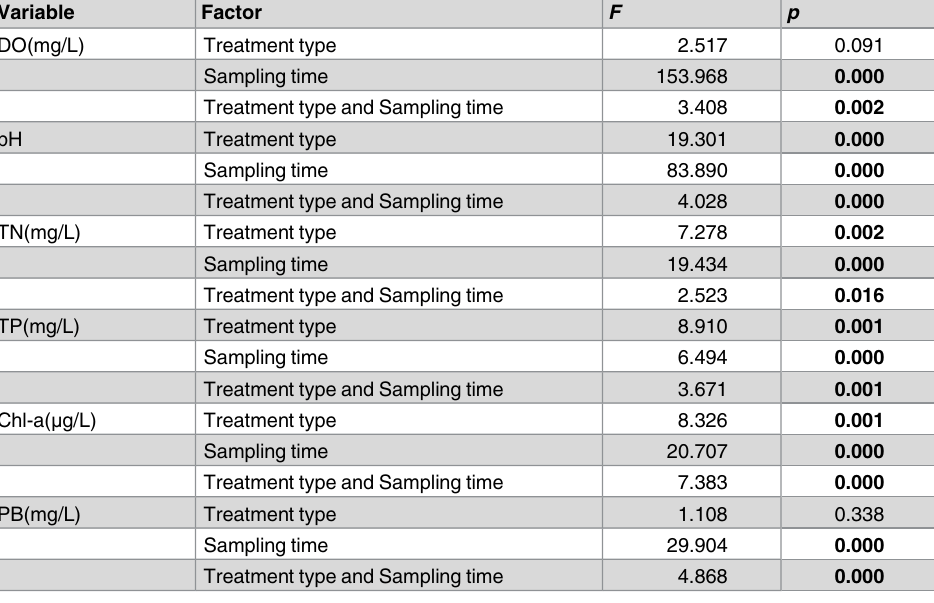
The P/A values for DO, pH, TN and TP for all treatments were shown in Fig 2. In all ten treat- ments, the P/A values of DO (RDO) decreased for the first week (before June 18), increased rapidly to the maximum value (0.07–0.24) in the subsequent two or three weeks and then Table 3. Results of Two-way analysis of variance(Two-way ANOVA) examining the effectsof different treatment types and the different sampling times on the variations of environmental parameters.